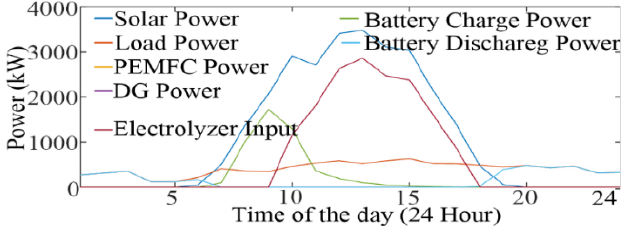
Figure 16. Power generation and consumption for one day: combination